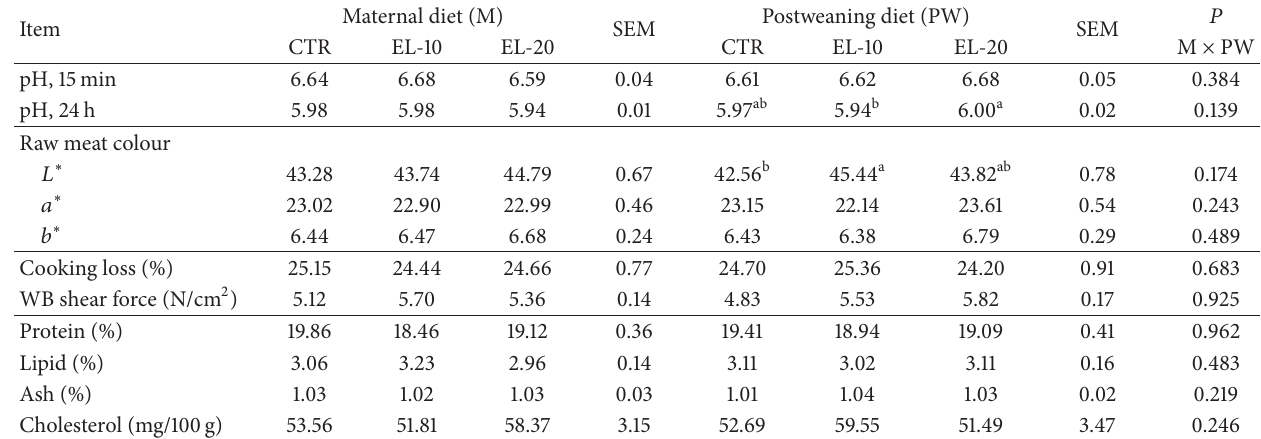
Table 4: Effect of maternal and lamb postweaning diets on meat quality traits of light lamb